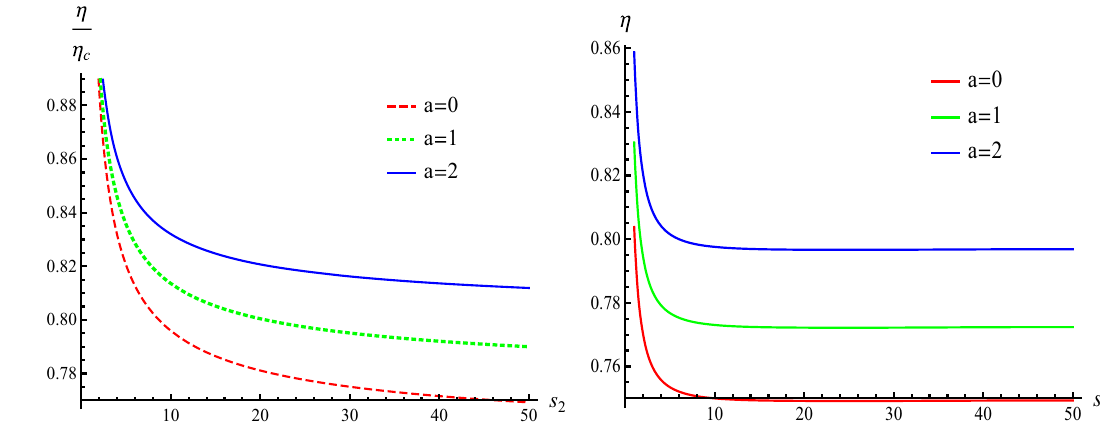
Fig. 4 The two figures above are plotted at three different fixed normalization factors a ; here we take P 1 = 4 , P 4 = 1 , S 1 = 1 , Q = 1 and state parameter ω q = − 1. The left figure corresponds to the ratio between efficiency η and η c , the right one to the efficiency η